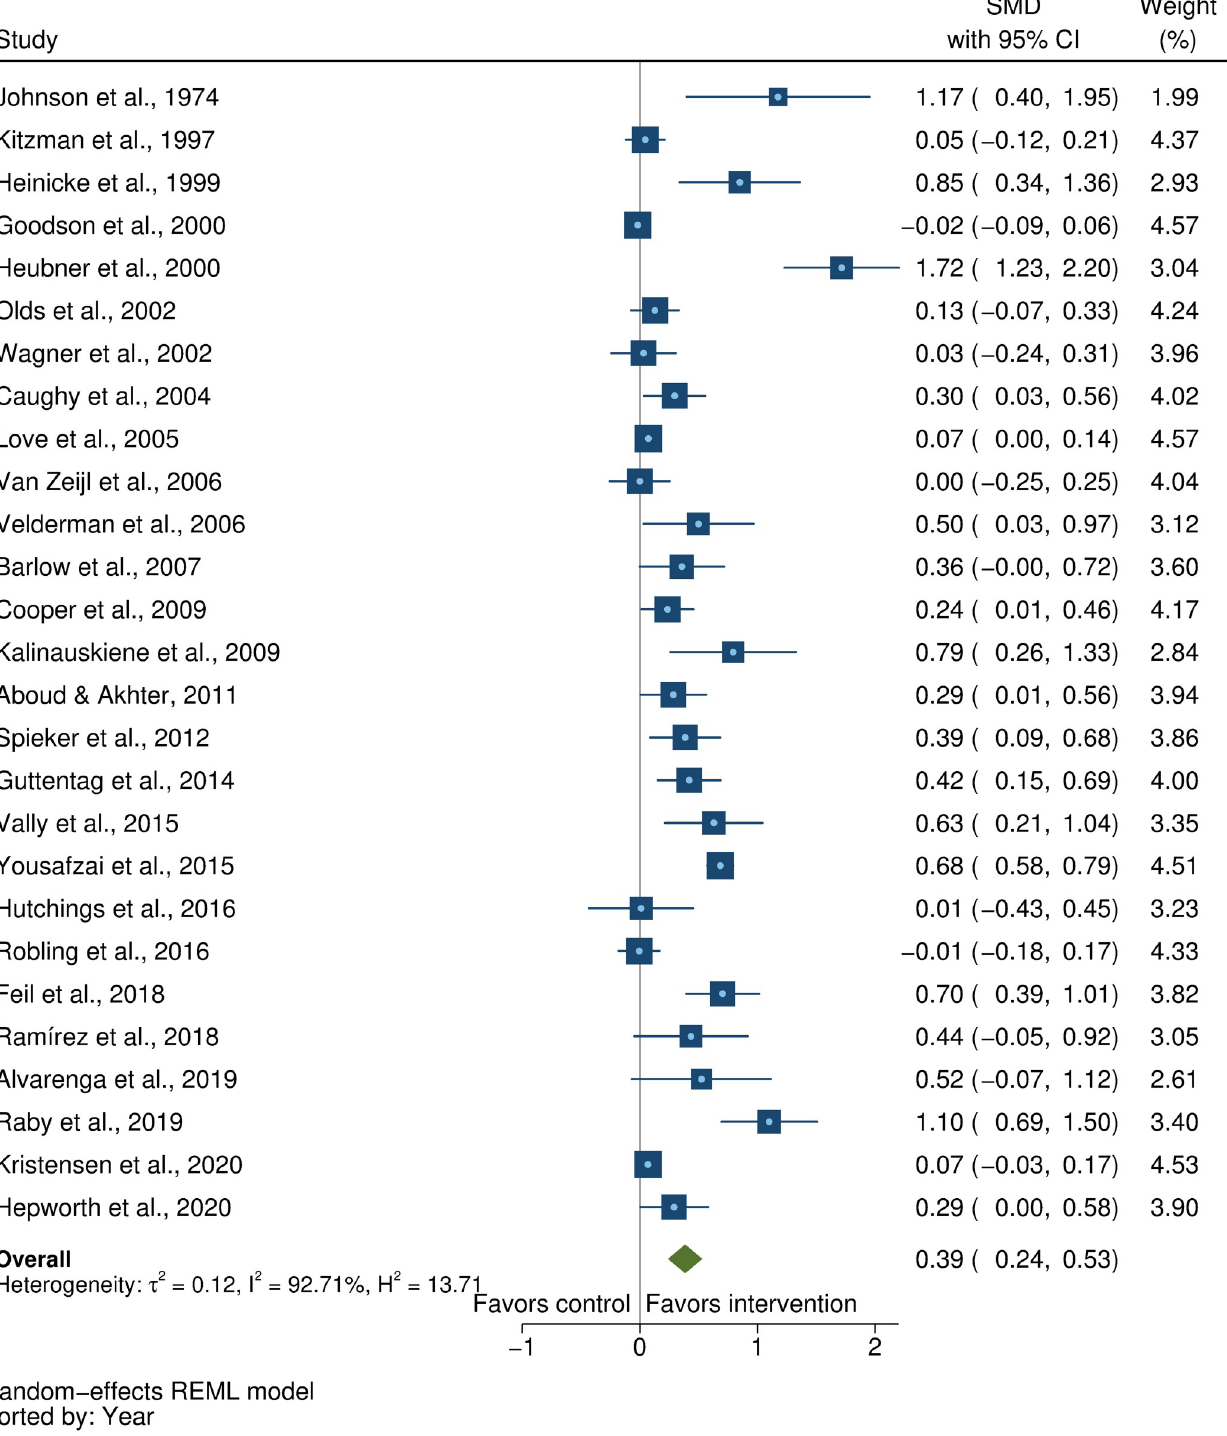
PLOS Medicine| https://doi.org/10.1371/journal.pmed.1003602 May 10, 2021 33 /